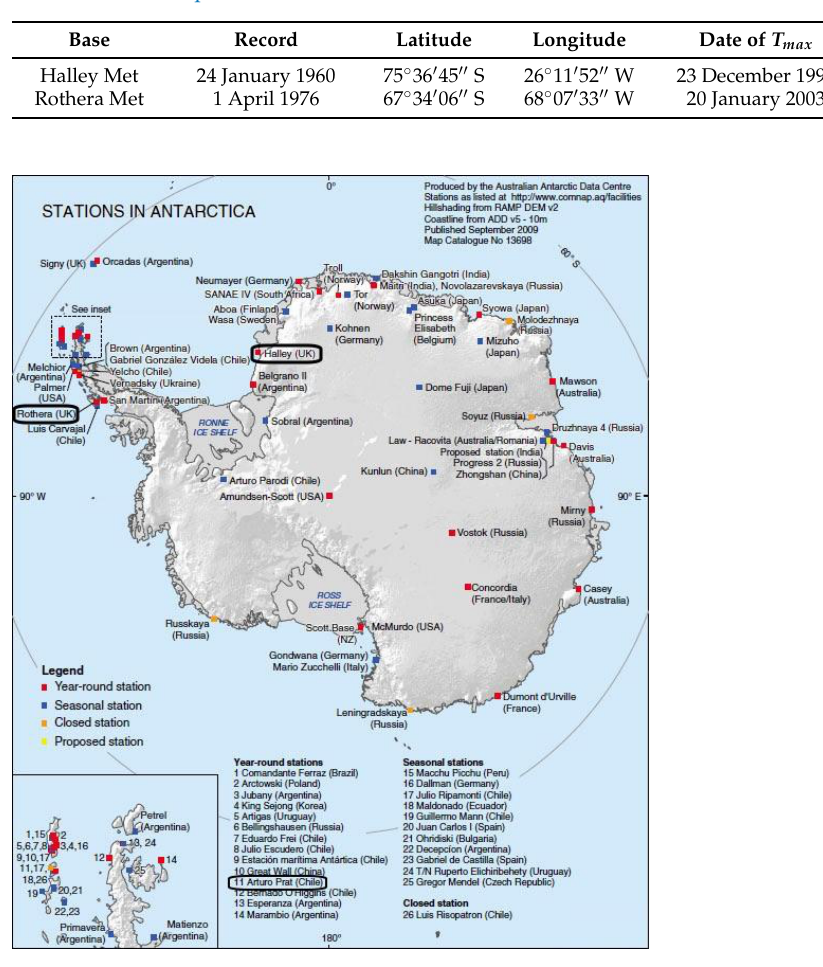
Table 1. Information about the used dataset, namely the names of Antarctic bases, the dates since from temperatures are available, latitude and longitude of the bases, the date of the maximum registered temperature and the maximum registered temperature over the considered period. Data are available at http://basmet.nerc-bas.ac.uk/sos/.